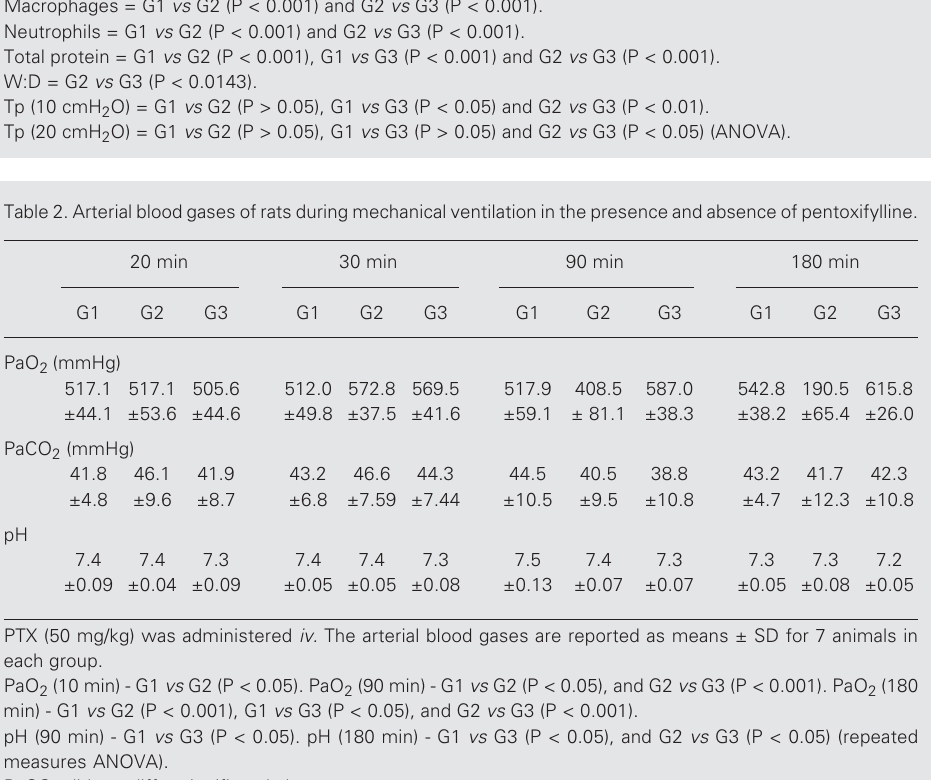
PaCO 2 did not differ significantly between